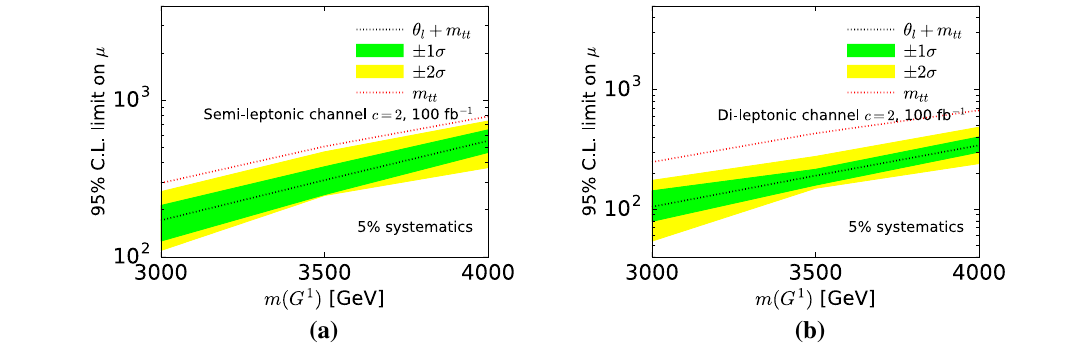
Fig. 9 Limits on μ for a wide ( c = 2) G 1 using the semi-leptonic ( a ) and di-leptonic ( b ) analyses for a fixed luminosity of 100 fb − 1 with 5% systematics on the total cross section (propagated to bins as explained